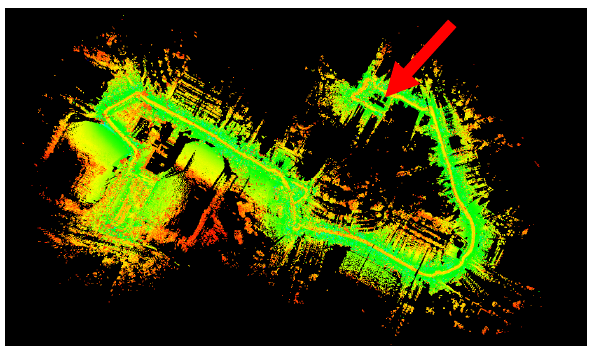
Figure 4: 3D point cloud acquired from a MLS system, the arrow highlights the building of interest (colour indicated different intensity